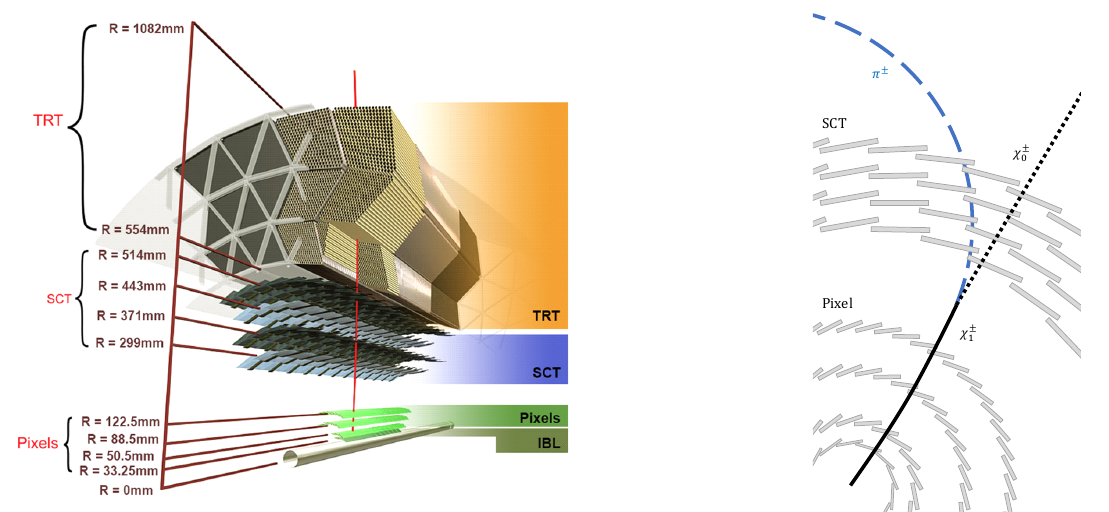
Figure 1 . Left: ATLAS inner tracking detector. The relevant layers in this analysis are the In- sertable B-Layer (IBL) and pixel tracking layers, within which the tracklets are contained. Track- lets consisting of any hits in the semiconductor tracker (SCT) layers are vetoed. Figure taken from ref. [15]. Right: illustration of a chargino decay giving rise to a 4-hit